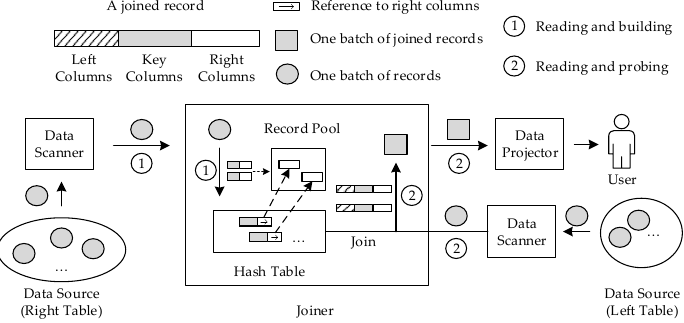
Figure 2. A typical implementation of the join operator of vectorized